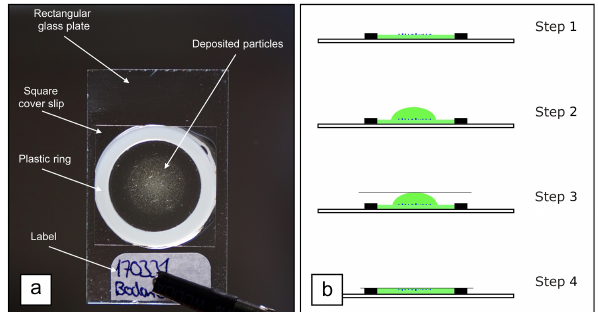
Figure 5. (a) Top view of a particle-loaded sample carrier compris- ing a common microscope slide and a plastic ring with gelatine used as the particle embedding layer, covered with a transparent micro- scope cover slip (square). (b) Post-sampling treatment steps 1 to 4 of the particle-loaded sample carrier that avoid contamination and allow preservation are shown as cross sections through a sample car- rier. Highlighted in green is a gelatine layer in which the collected particles (blue dots) are embedded. Step 1: sample carrier immedi- ately after particle collection with deposited particles exposed. Step